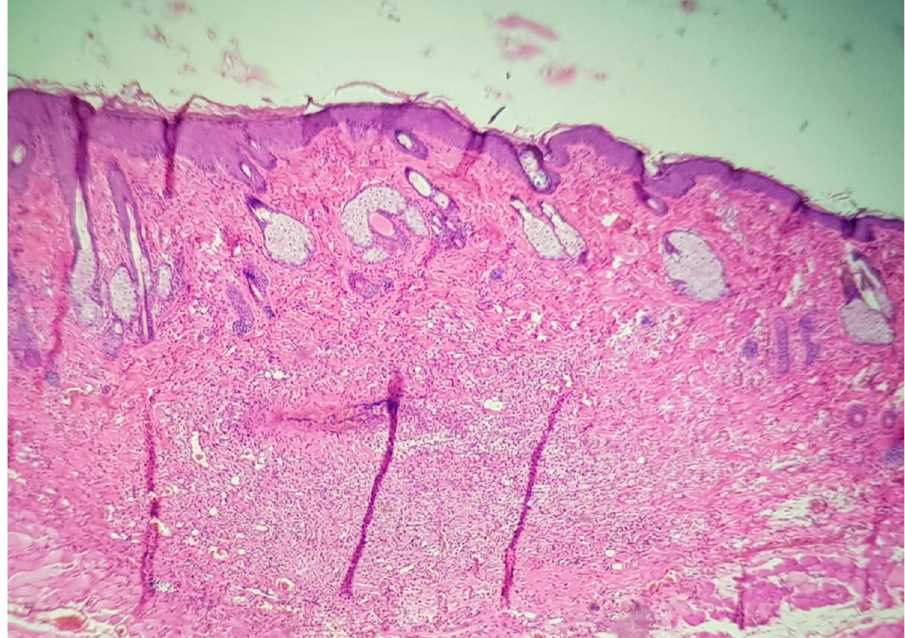
Figure 6. Histological image illustrating skin with granulate tissue in dermis on the 14th day after operatory procedure (20×).